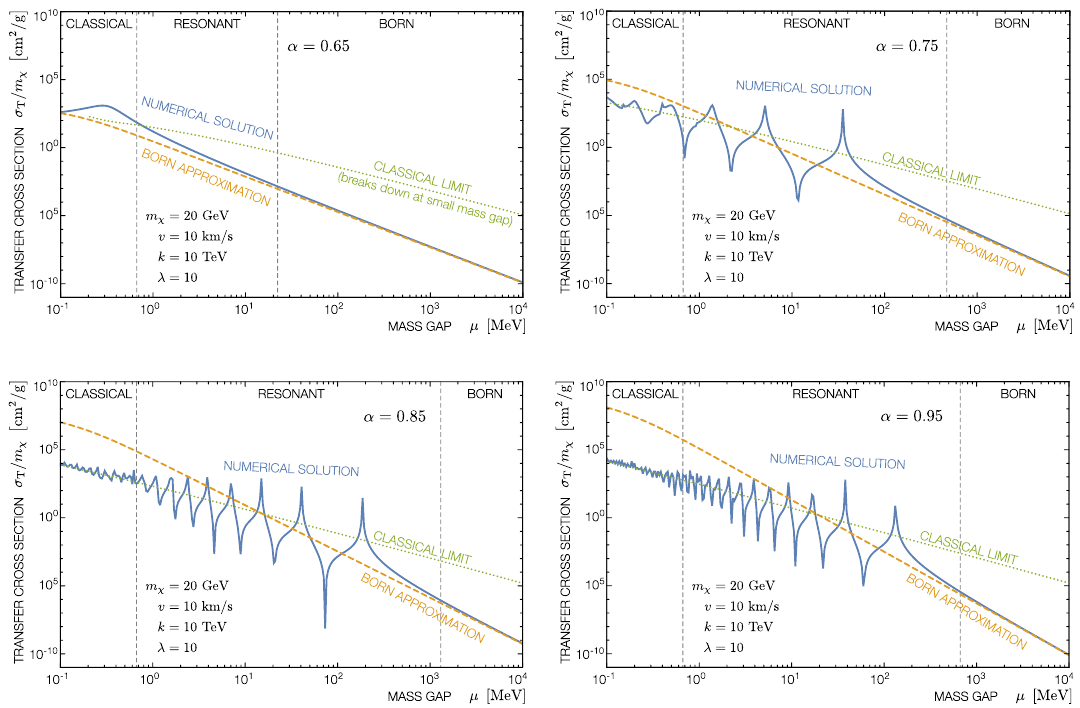
Figure 5 . Comparison of the numerically calculated transfer cross section to the analytic approx- imations introduced in figure 3. The general behavior displays distinct regimes, similar to that of a single mediator, see e.g. ref. [9, figure 2]. The blue line is the numerical solution. Orange (dashed)/green (dotted) lines correspond to analytic Born/classical approximations valid in their respective regimes; (6.8) and